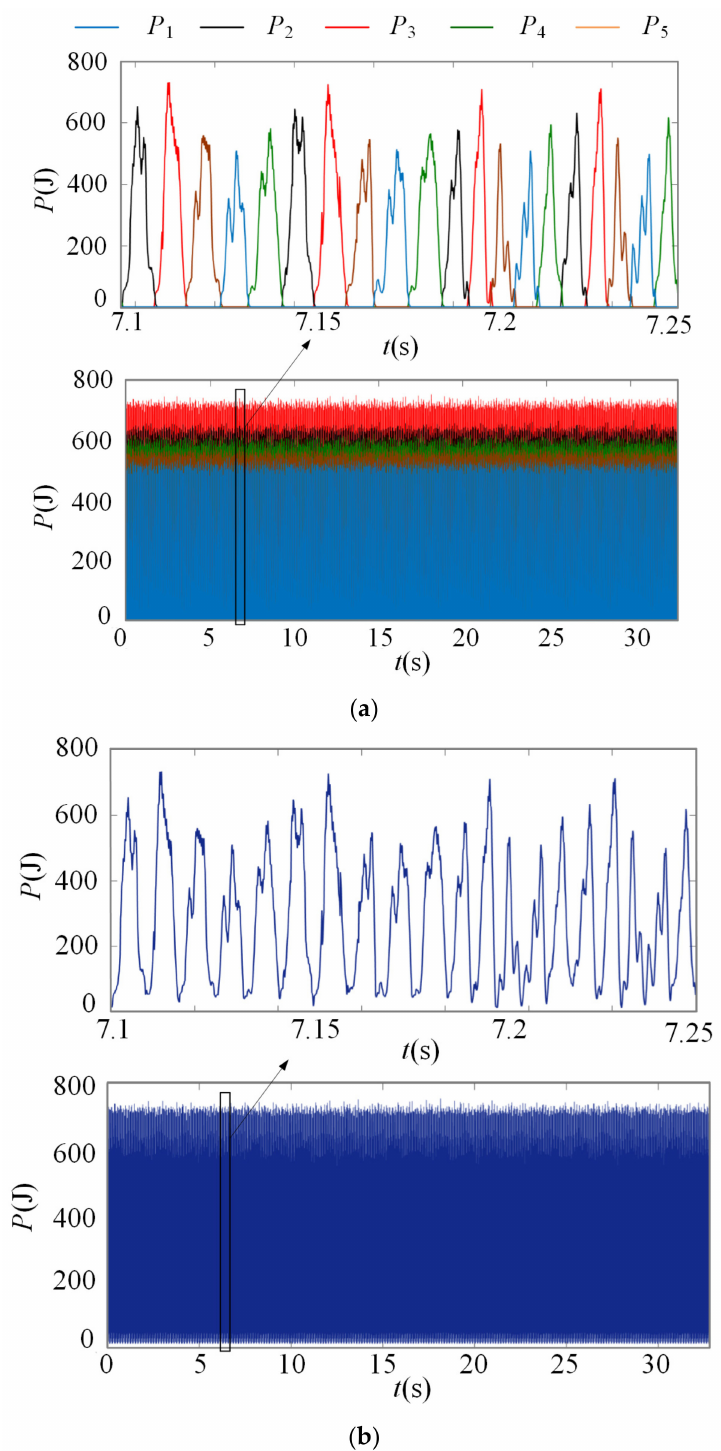
Figure 12. Results of main cutting force energy consumption of milling cutter and cutter teeth of scheme 2, ( a ) energy consumption of cutter teeth, ( b ) energy consumption of milling